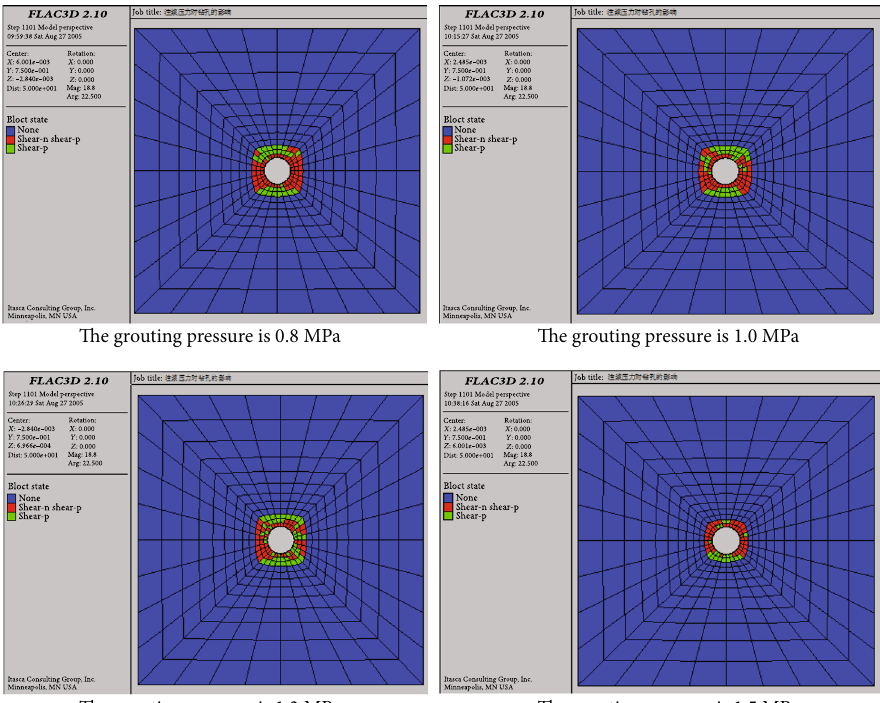
Figure 2: Distribution map of the plastic zone.